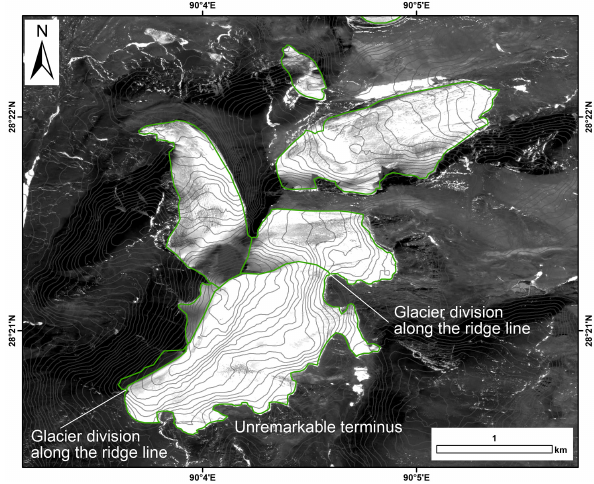
Figure 5. Separation of connected glaciers in our study site. Basic separation is performed along ridge lines identified by contour lines. Glacier surfaces with vague termini were not